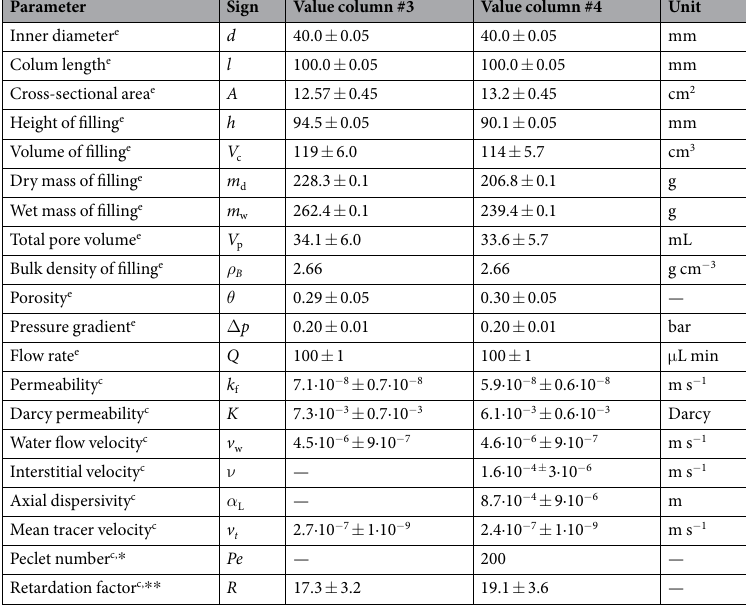
Table 2. Exemplary geometrical and hydrodynamic parameter for the artificial soil column as used in the PET experiments #3 and #4 with the reactive [ 64 Cu](Cu-MCPA 2 ) tracer (suffix e = experimental data, c = calculated). * The Peclet number Pe was derived from the axial dispersivity of α L = 8.7·10 − 4 m, the interstitial velocity of v = 1.6·10 − 4 m s − 1 , and a molecular diffusion coefficient for MCPA of D m = 6.8·10 − 10 m 2 s − 1 . ** The retardation factor was calculated as ratio between mean water and mean tracer velocities.